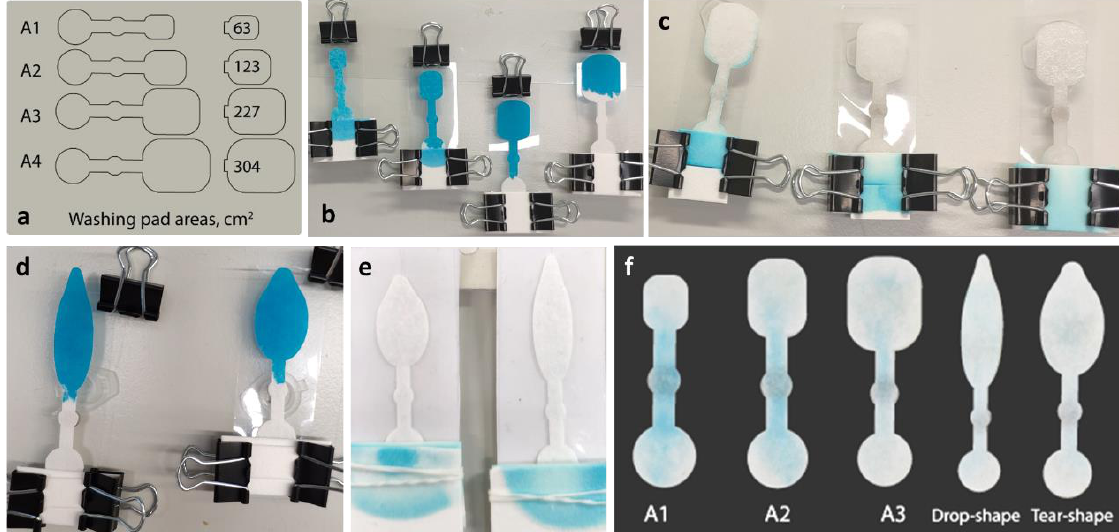
Figure 3. Production of the microfluidic paper device. ( a ) Design of paper devices with washing pads of increasing areas (A1 – A4) and ( b ) their absorption capacity after adding MBs in 100 µL of a stained solution. ( c ) Device A3, in which the 100 µL of MB stained solution has been washed away after four consecutive additions of washing buffer of, from left to right, 50, 100, and 200 µL each, while the MBs are retained magnetically in the detection zone (Figure S3). ( d , e ) Tear-shaped and drop-shaped devices before ( d ) and after ( e ) the stained solution has been washed away (4 washes, 100 µL each). ( f ) Background noise obtained for the magneto- immunoassay, carried in 100 μL of lysed whole blood (diluted 1:100) after washing 4 times (100 μL each) and adding TMB substrate solution. Pictures of drop- and tear-shaped devices are not to scale.